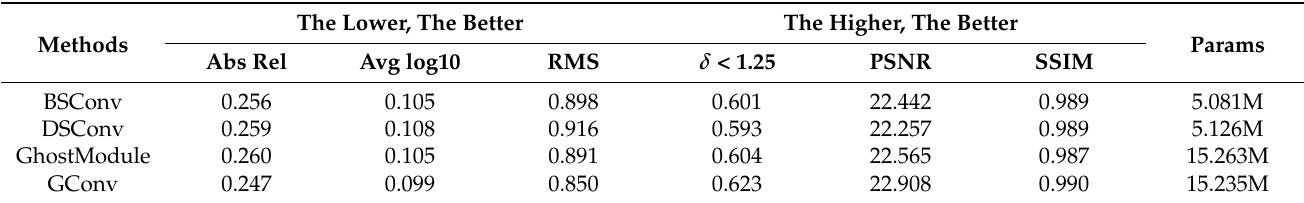
Table 5. Comparison of the different lightweight